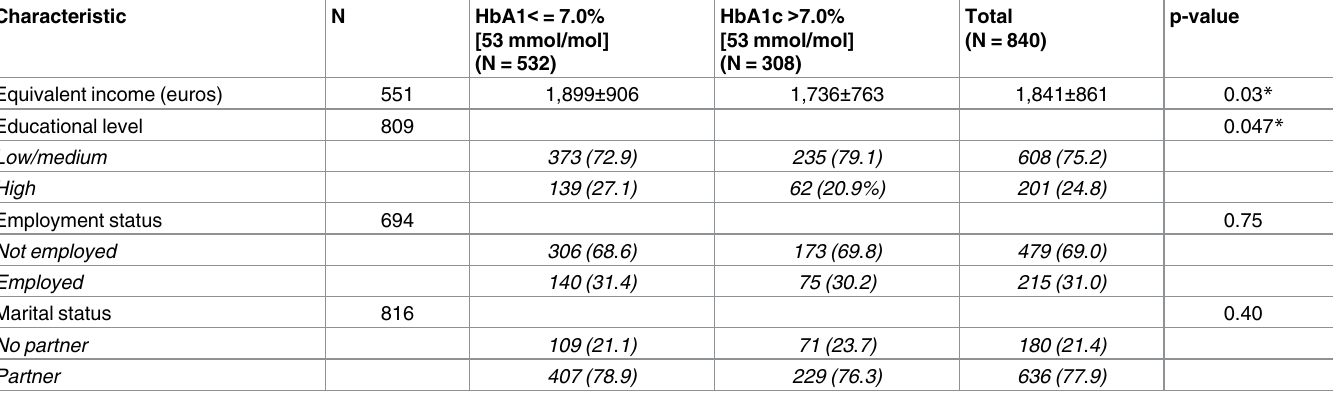
Table 2. Context-related patient characteristics by glycaemic control.